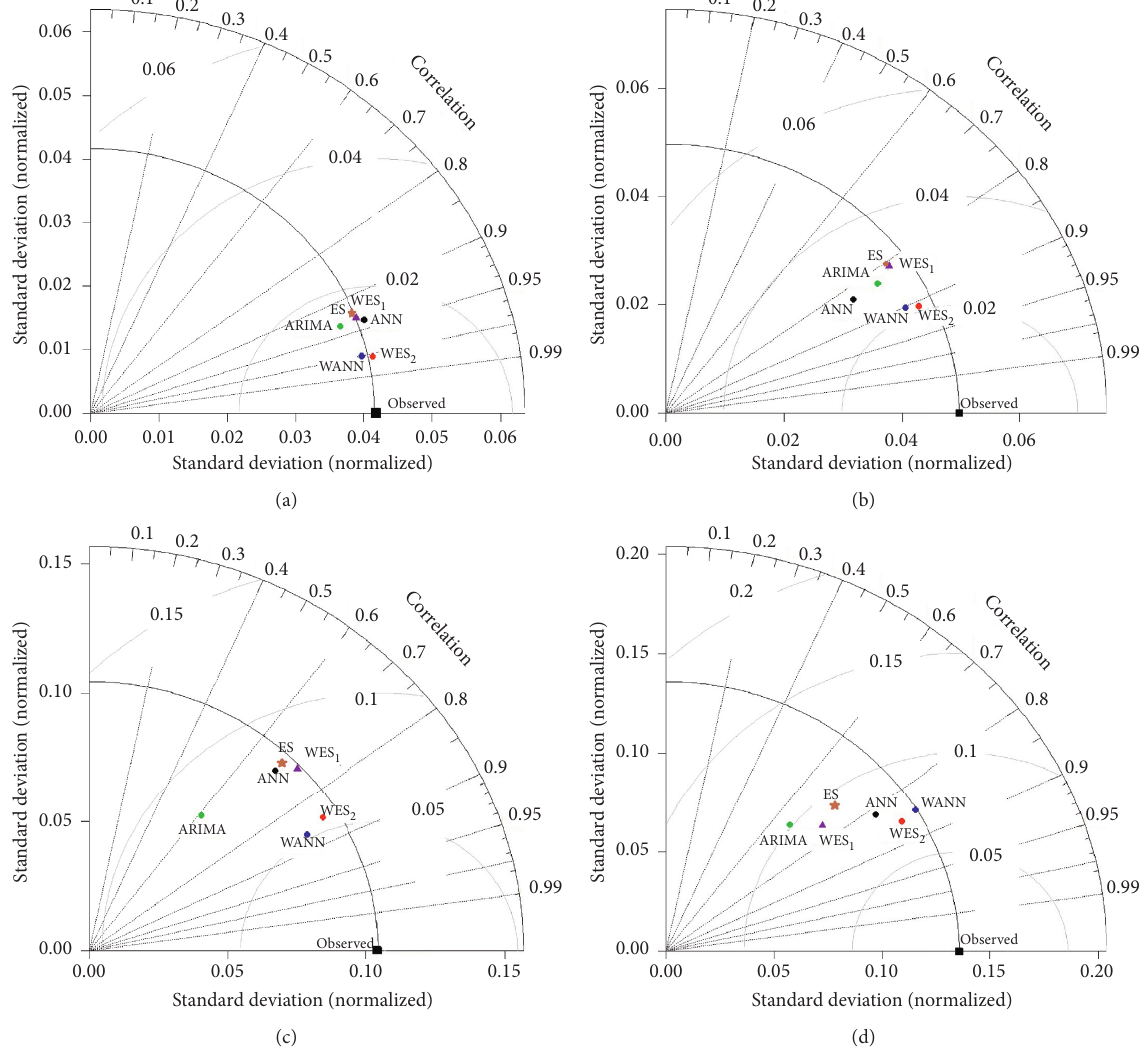
Figure 9: Taylor diagrams of the streamflow models. (a) Daily streamflow of Trinity. (b) Daily streamflow of West Nishnabotna. (c) Monthly streamflow of Trinity. (d) Monthly streamflow of West